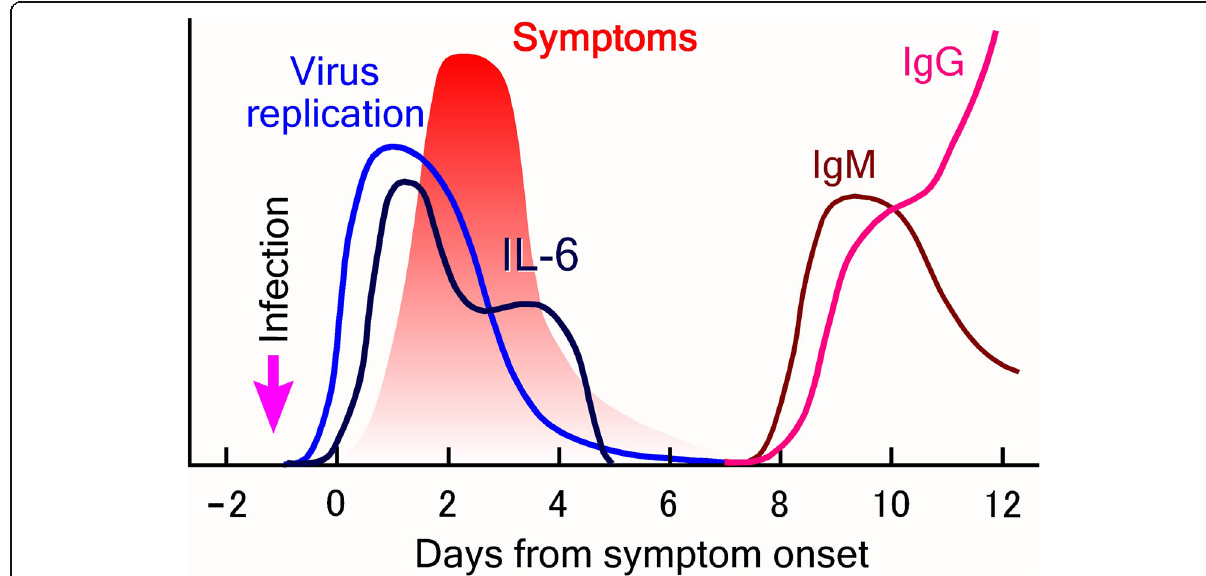
Fig. 1 Diagrammatic representation of the kinetics of IAV infection. Time course of virus replication, cytokine production, and Ab responses